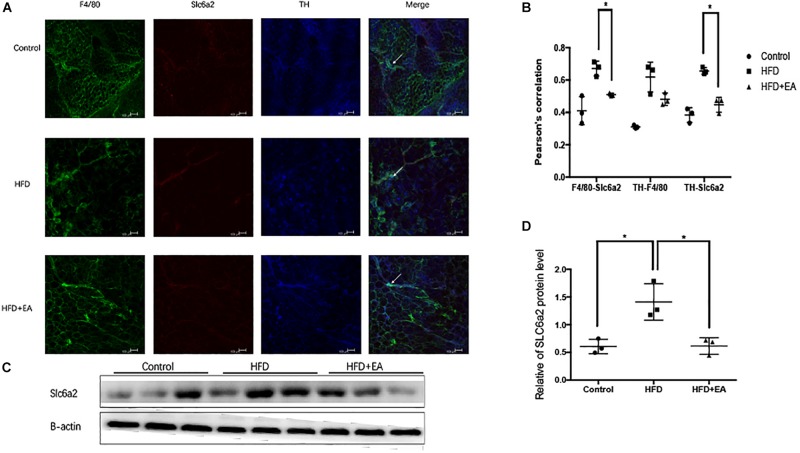
Effect of EA on SAMs. (A) Representative images of showing F4/80 (green), Slc6a2 (red), and TH (blue) fluorescence. The white arrows in the merged image indicate SAMs. (B) Correlation between F4/80 and Slc6a2, Slc6a2 and TH, and TH and F4/80, as indicated by Pearson correlation analysis (n = 3, *P < 0.05). (C) Immunoblot image of Slc6a2 staining. (D) Relative protein level of Slc6a2 (in the control, HFD, and HFD + EA groups) (n = 3, *P < 0.05).